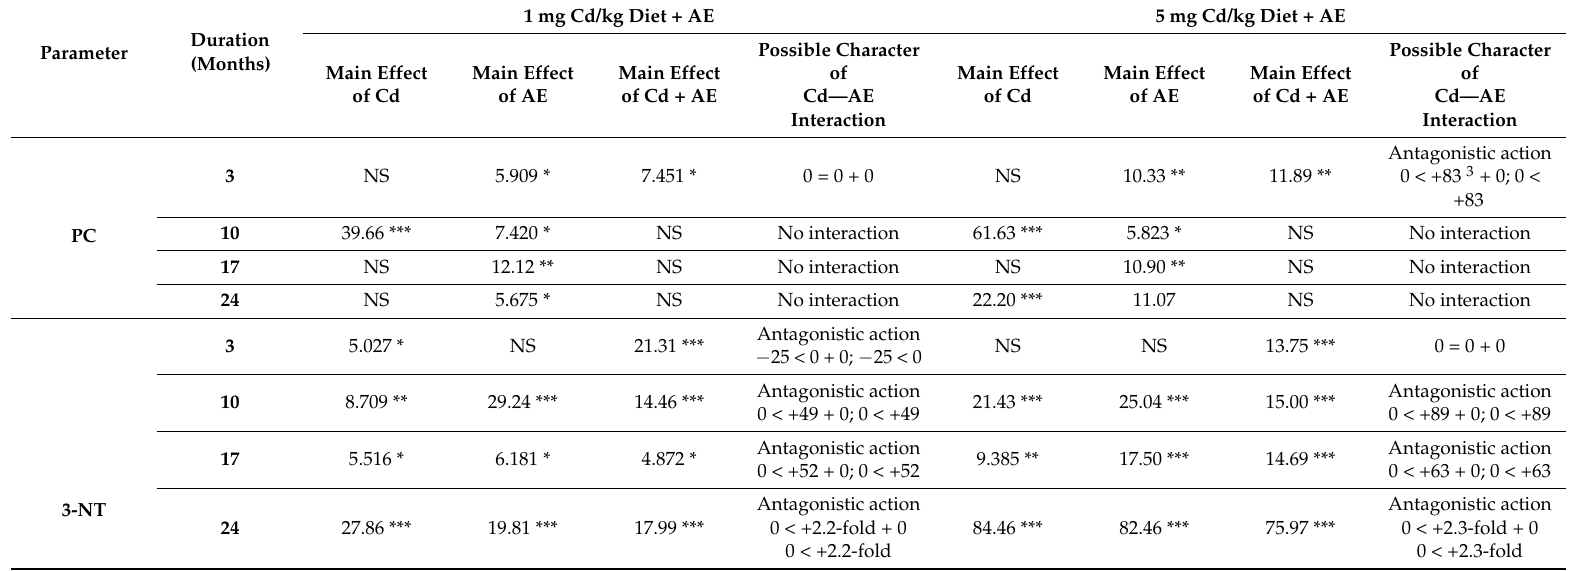
Table 2. Main and interactive effects of cadmium (Cd) and the extract from Aronia melanocarpa L. berries (AE) on the concentration of protein carbonyl groups (PC) and 3-nitrotyrosine (3-NT) in the liver of female rats. 1,